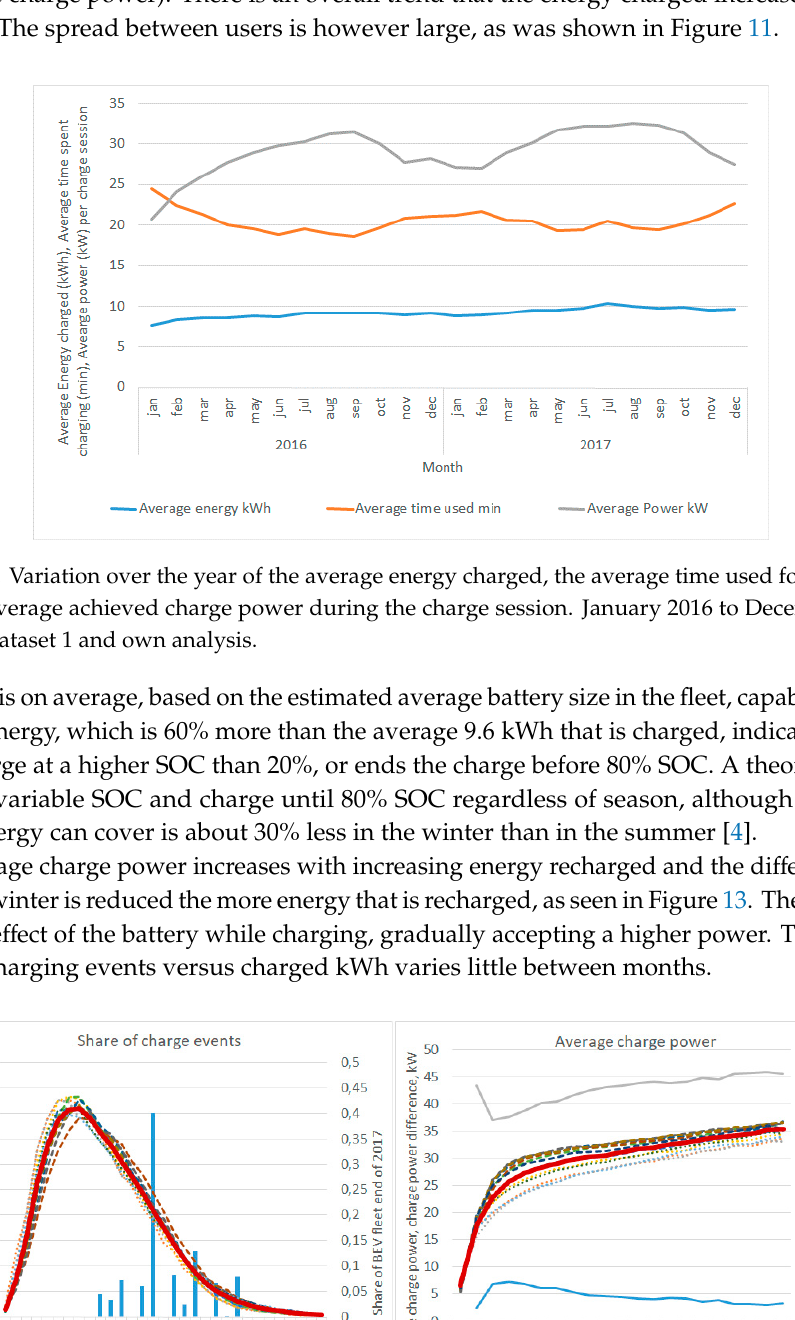
Figure 13. ( Left ) Share of total charge events in each month of 2017 and the average for 2017 (left y- axis) as a function of the average kWh charged (x-axis), and the spread of the BEV fleets capacity to accept fast charge assuming that 60% of the total battery capacity is rechargeable (right y-axis) as a function of the kWh charged (x-axis). ( Right ) Average achieved charge power per month and for the whole of 2017 (y-axis), deviation in charge power in August compared with February, and Charge power in February in percentage of August, as a function of the kWh charged (x-axis). Source: Dataset 1 and own analysis.